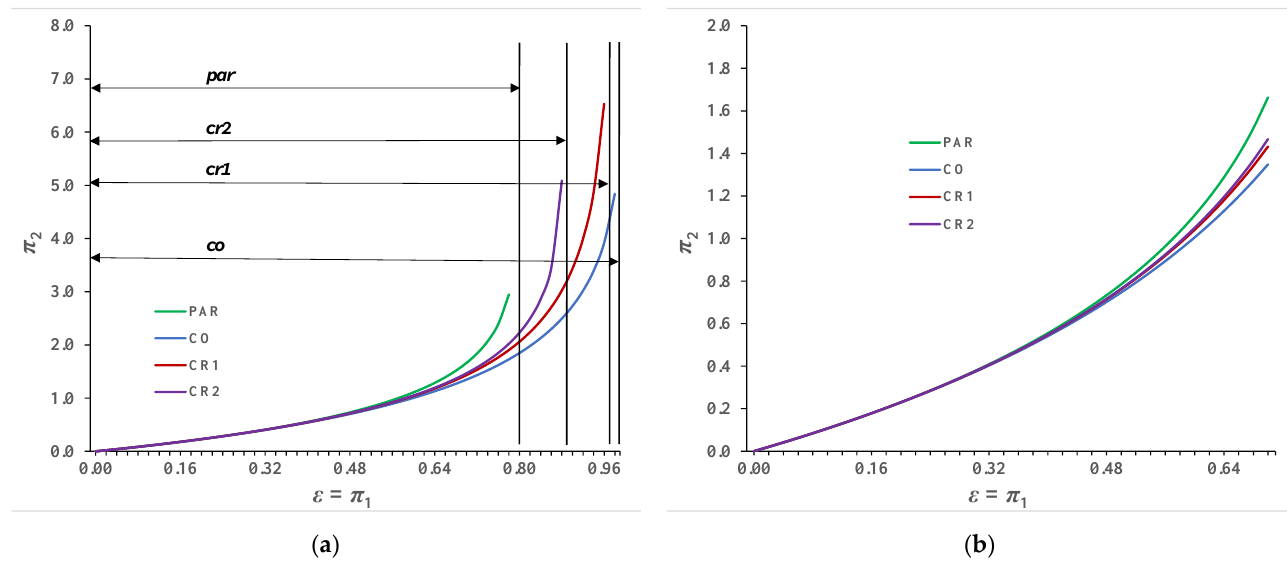
Figure 15. Dependence of π 2 on effectiveness of recuperator with π 3 = 0.25: ( a ) 0 < ε < 1.0; ( b ) 0 < ε < 0.7.